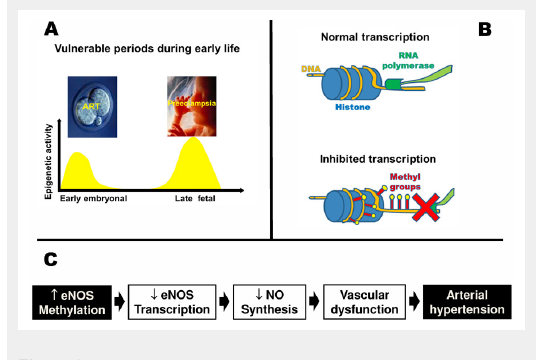
Role of epigenetic alterations in the fetal programming of vascular dysfunction. Vulnerable periods during early life known to be associated with fetal programming of cardiovascular disease coincide with increased epigenetic activity (Panel A). Increased DNA methylation inhibits transcription (Panel B). In mice conceived by assisted reproductive technologies, DNA-methylation of the eNOS gene was altered resulting in decreased eNOS transcription in the vasculature and impaired vascular nitric oxide